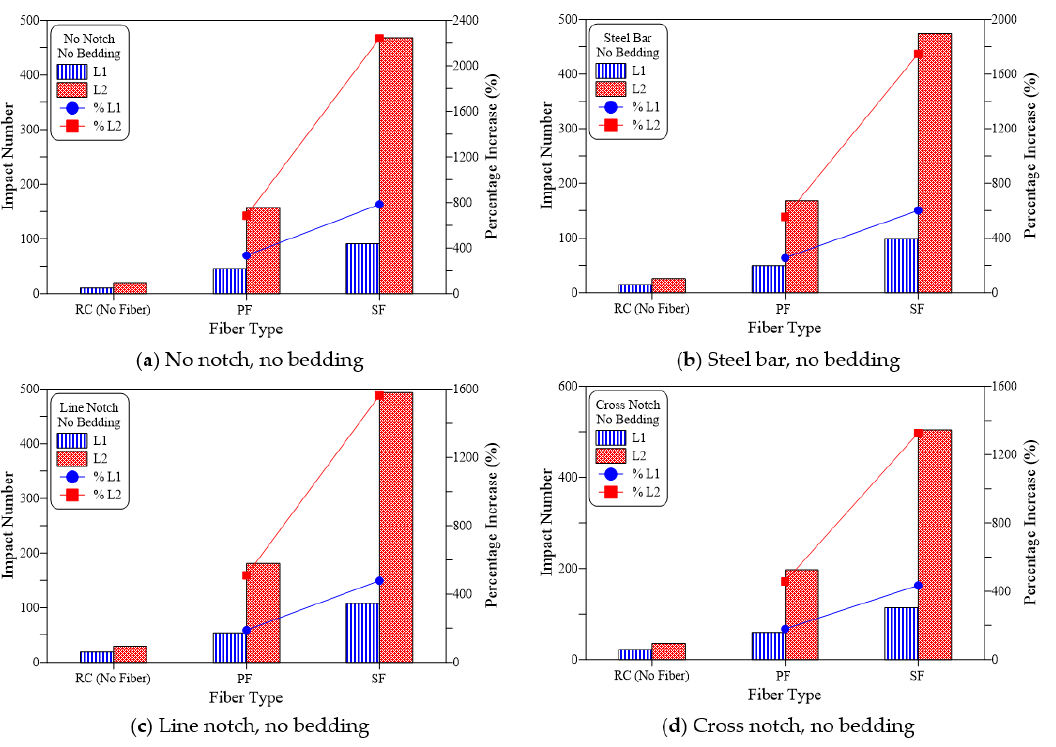
Figure 9. Fiber type effect on cracking and failure impact numbers of no bedding specimens ( a ) No notch, no bedding, ( b ) Steel bar, no bedding, ( c ) Line notch, no bedding ( d ) Cross notch, no bedding.